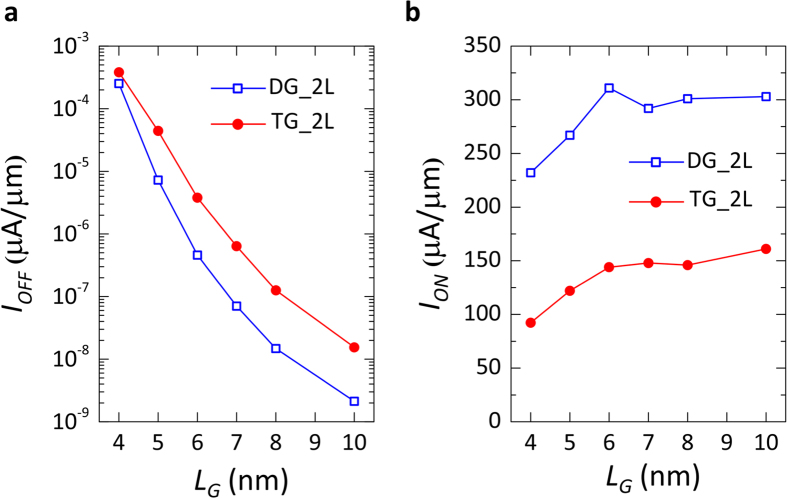
Benefits of double-gate geometry in 2L-WSe2
n-type FETs.(a) Comparison between IOFF extracted at VCG = −0.2 V and VPG = 1 V for top- and double-gate devices, at different gate lengths. (b) Comparison of devices ION extracted at VCG = 0.8 V and VPG = 1 V at different gate lengths.